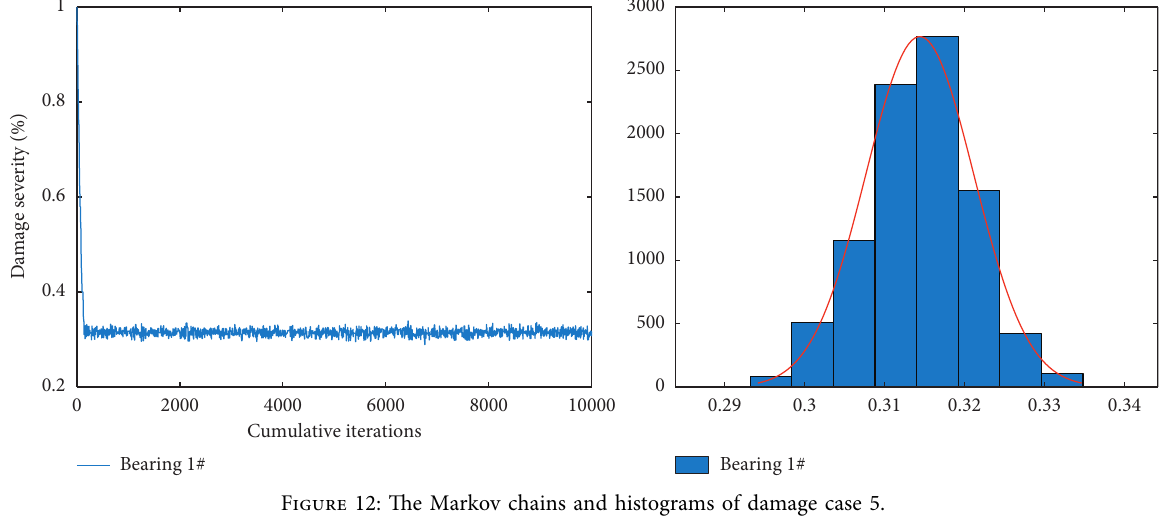
Figure 12: The Markov chains and histograms of damage case 5.